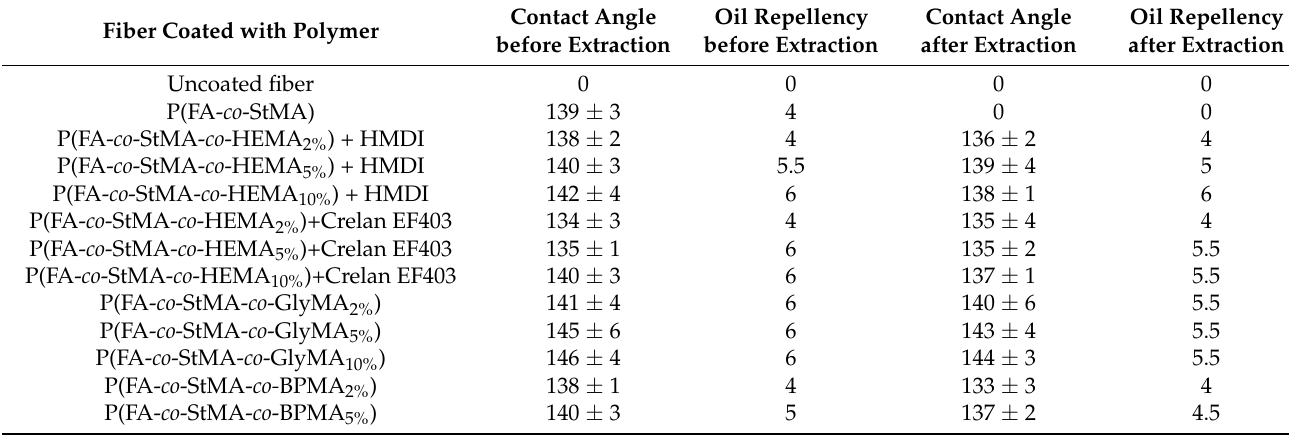
Table 4. List of the contact angles against water for the non-extracted and extracted cellulose fibers, as well as the oil repellency of the fibers tested with the hydrocarbon test (4 = n -tetradecane, 5 = n -dodecane, 6 = n -decane) before and after extraction for 24 h with